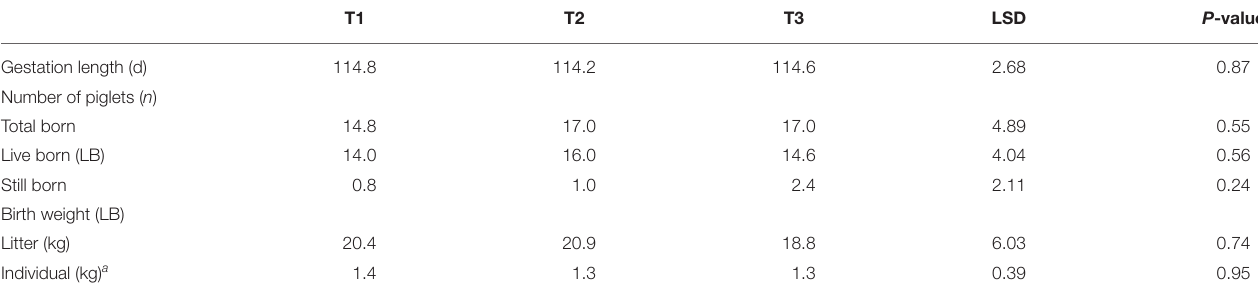
TABLE 4 | Effect of dietary treatment on performance of the sow at